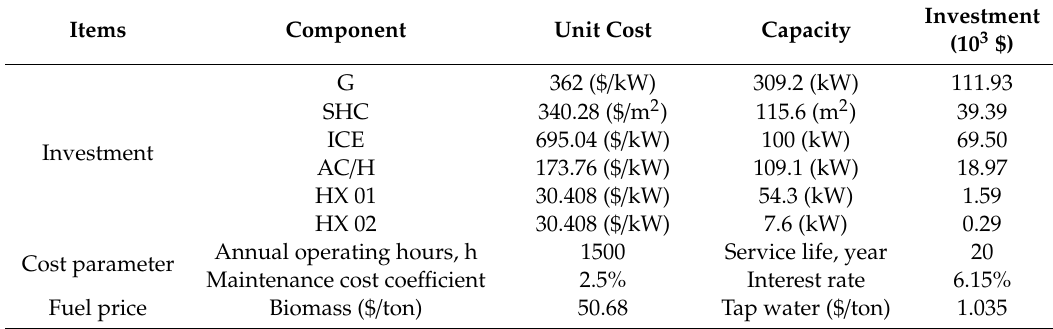
Table 4. System initial investment cost parameters and fuel price.